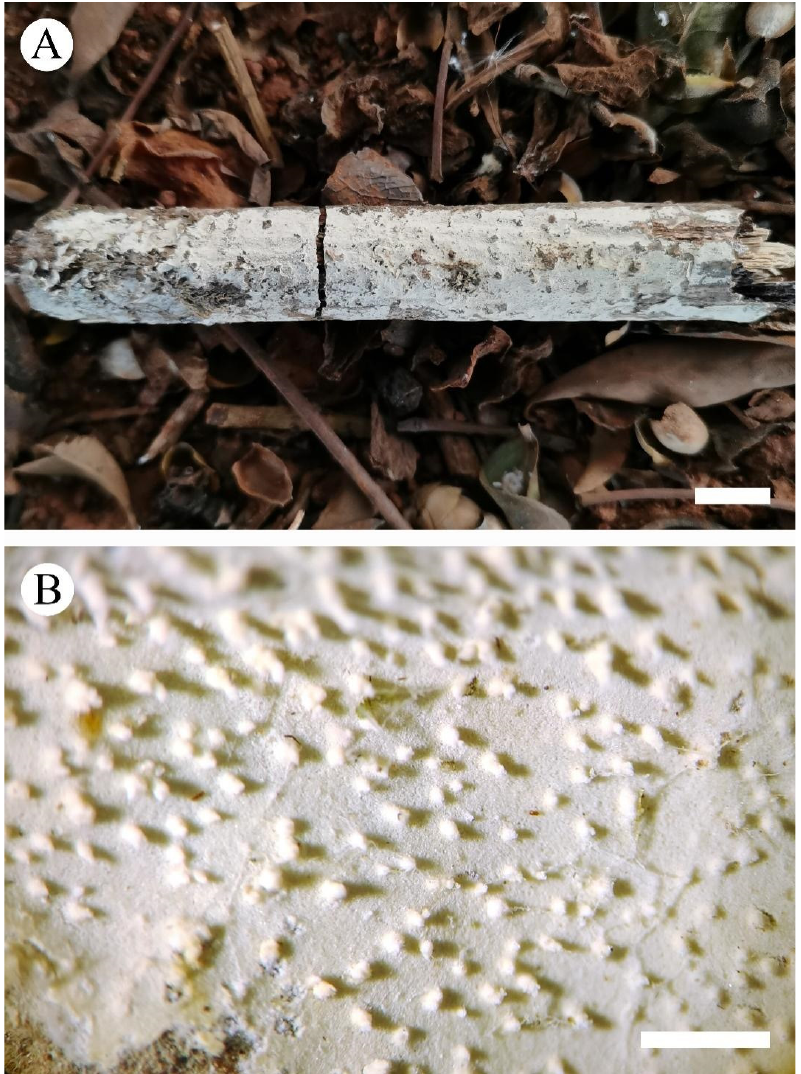
Figure 7. Basidiomata of Xylodon wenshanensis (holotype): the front of the basidiomata ( A ), charac- teristic hymenophore ( B ). Bars: ( A ) = 1 cm and ( B ) = 1 mm.